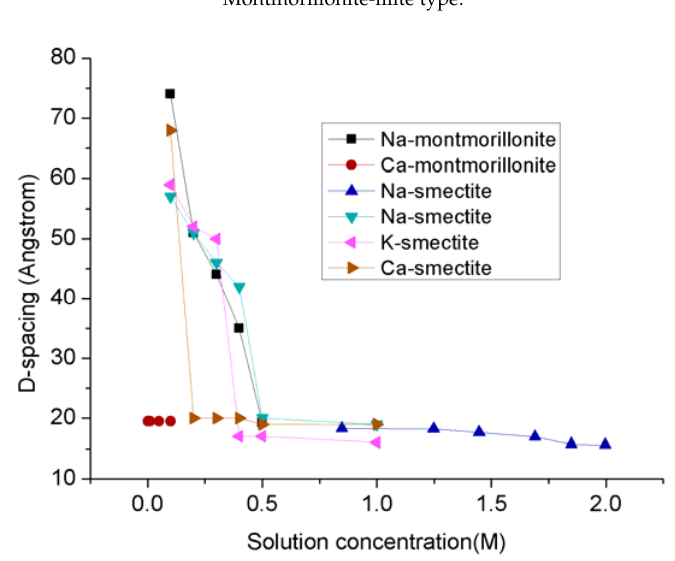
Figure 4. The D-spacing of clay minerals in solutions Figure 4. The D ‐ spacing of clay minerals in solutions [24,63,64].